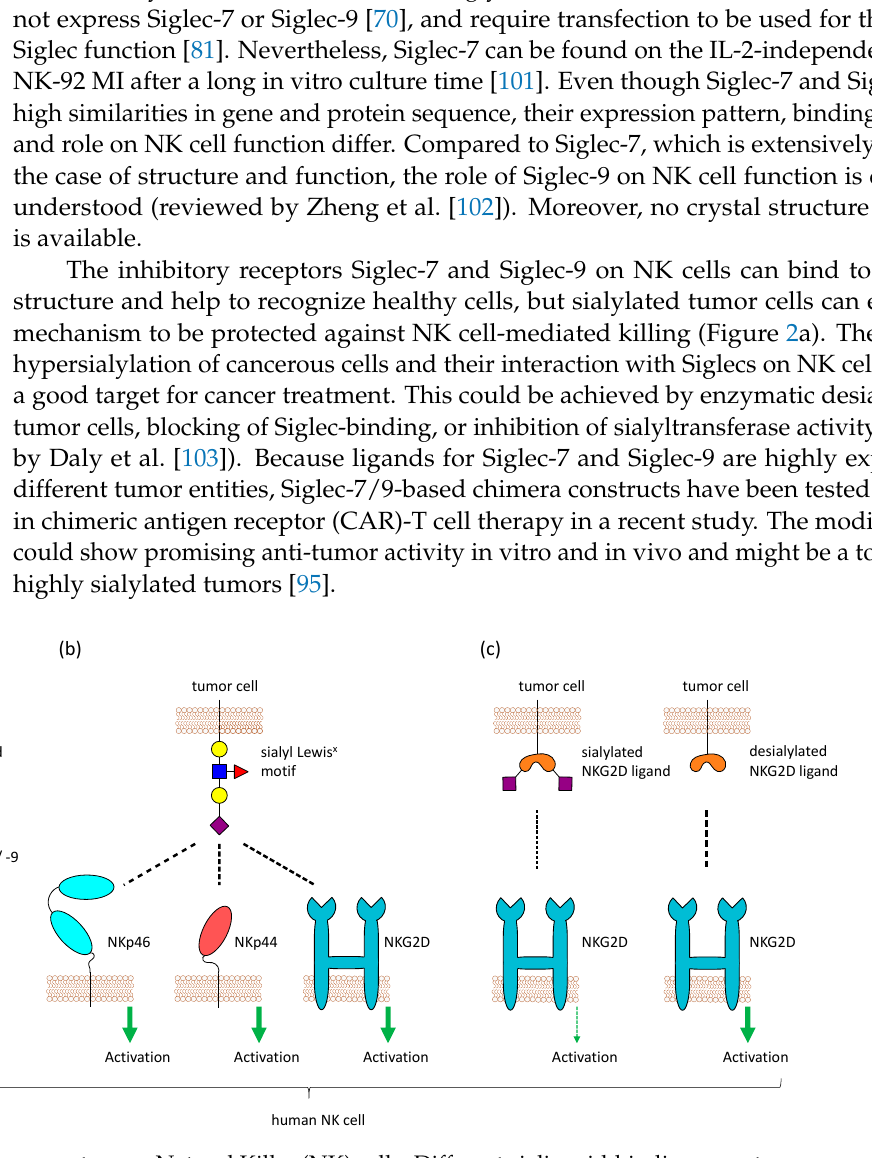
Figure 2. Sialic acid-binding receptors on Natural Killer (NK) cells. Different sialic acid-binding receptors are present on NK cells. ( a ) NK cells express Siglecs (mostly Siglec-7 and Siglec-9), which bind sialic acids and mediate inhibitory signals. Sialylated tumor cells can exploit these receptors to escape NK cell-mediated killing ( b ) One particular sialic acid motif, sialyl Lewis x , is detected by the activating receptors NKp46, NKp44, and NKG2D, leading to NK cell activation. ( c ) NKG2D usually binds stress-induced ligands like MICA, MICB, and ULPs. Binding of NKG2D to its ligands on tumor cells is reduced when these ligands are sialylated.